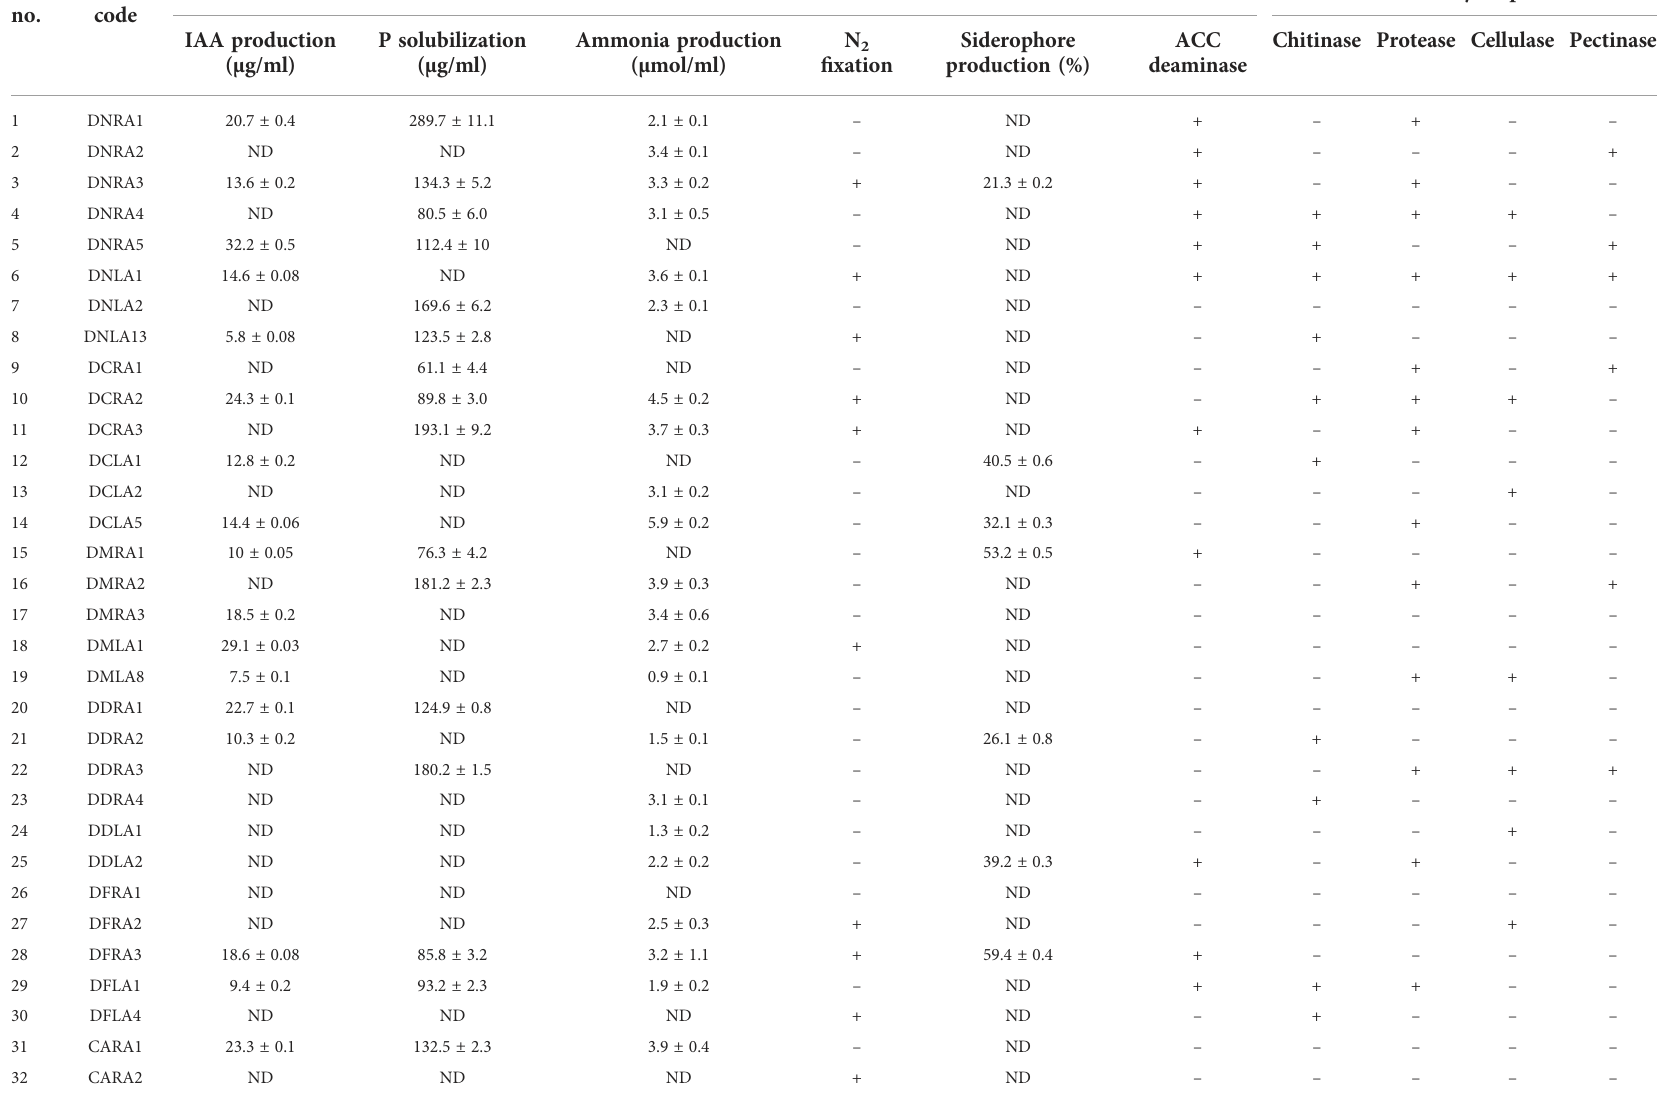
TABLE 2 Plant growth promotion traits and extracellular enzyme production by endophytic actinobacteria associated with orchid. Sl.